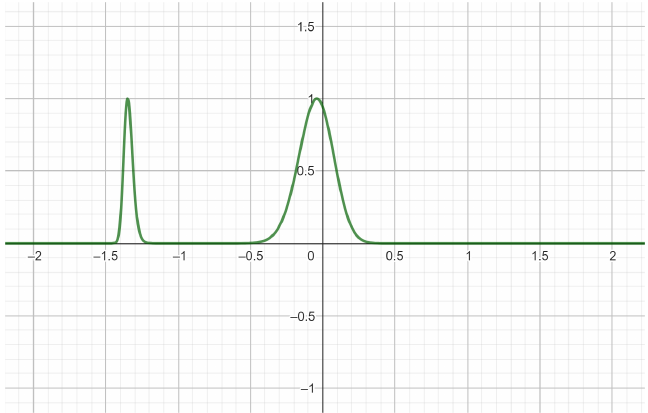
Figure 13. Graph of the function exp [ − ( 5 x + ( x − 1/2 ) 2 + x 6 ) 2 ] .